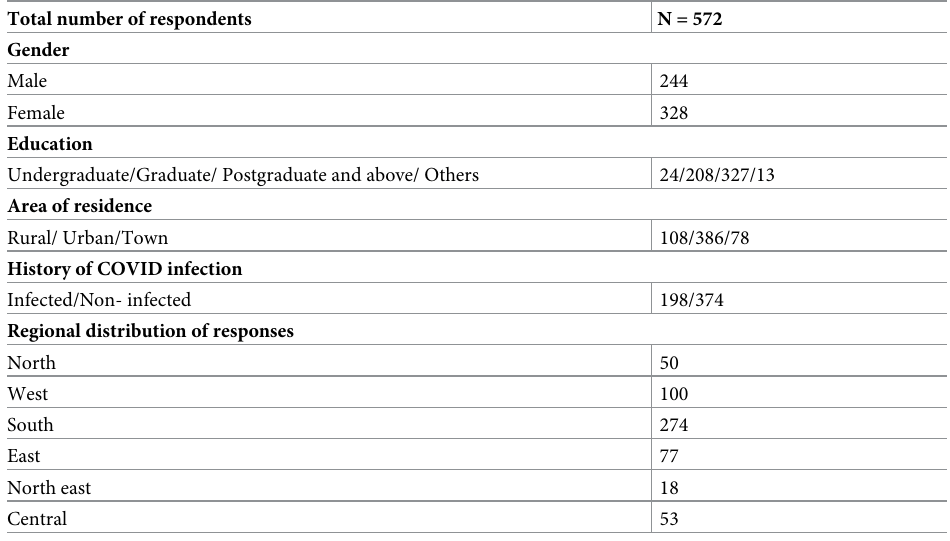
Table 2. Profile of the survey